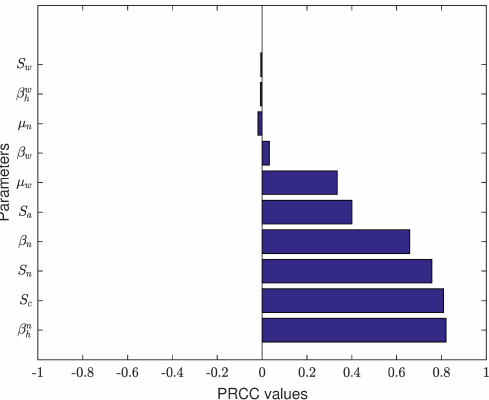
Figure 4. PRCC indices of Reproduction Number in the presence of vaccination and Wolbachia .